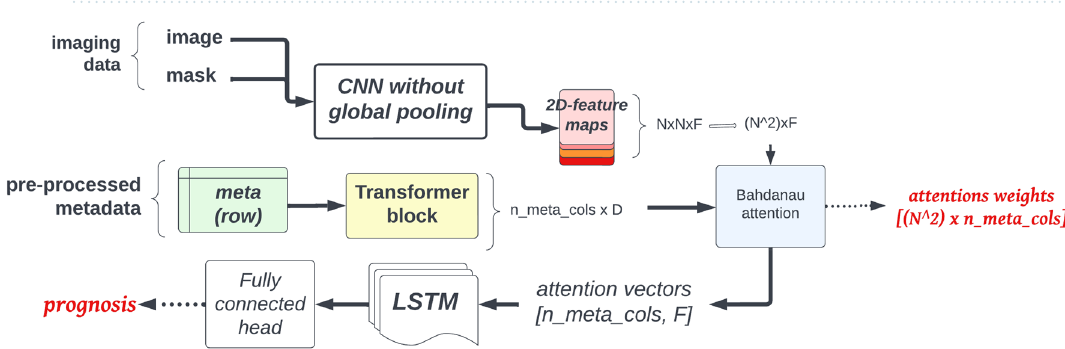
Figure 2. Our baseline model of the task at hand; the ’image-only’ model differs from this solely in the fact that the metadata input is not present, and not concatenated after post-processing to the other imagery based inputs.